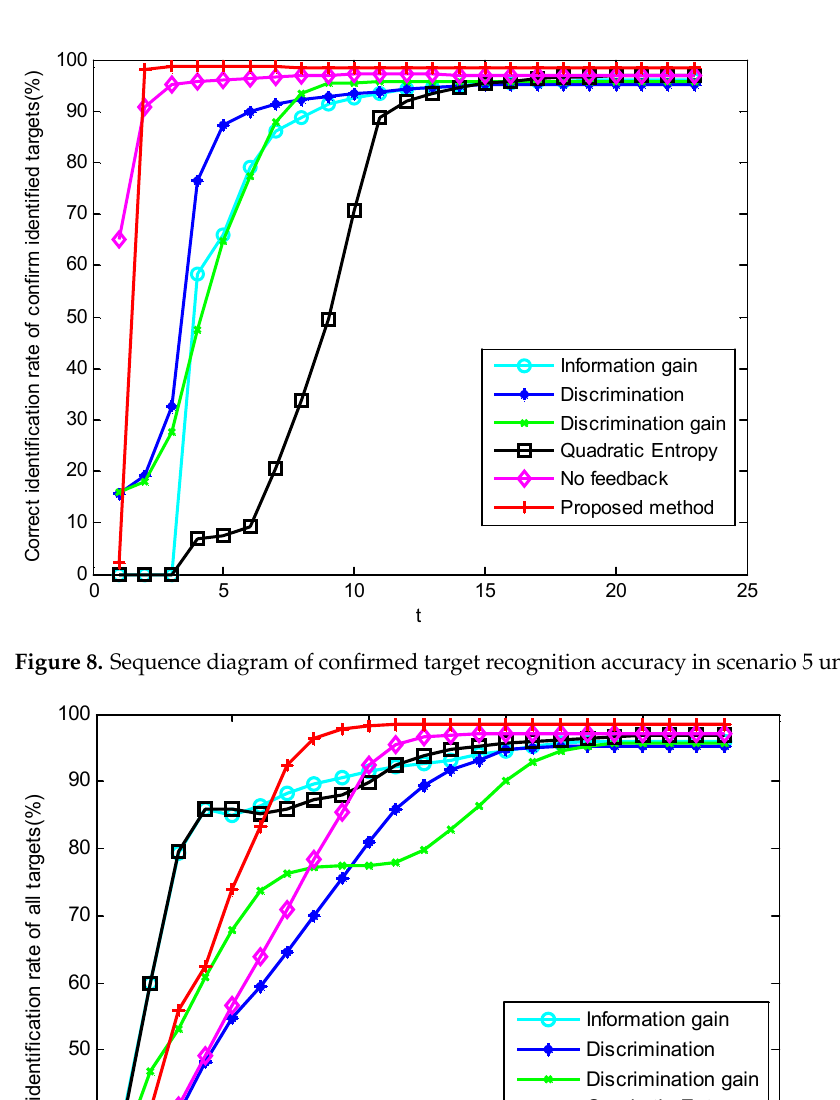
Figure 7. Sequence diagram of the number of confirmed targets in scenario 5 under condition 1.